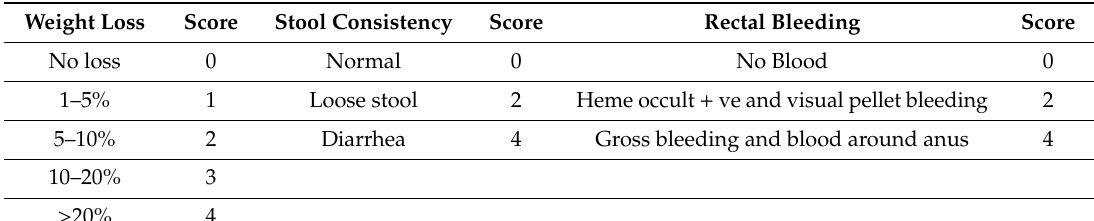
Table 1. Disease activity index